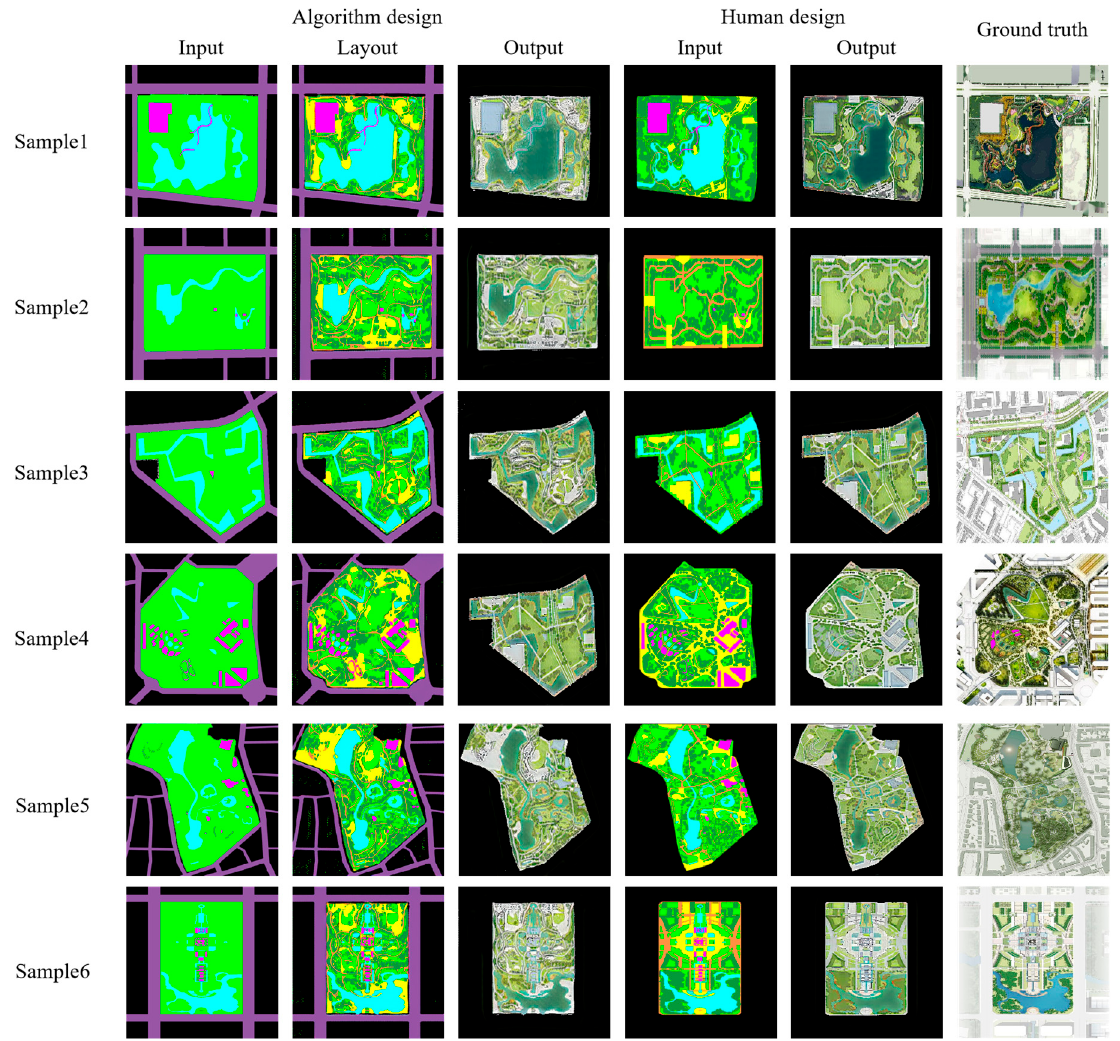
Figure 18. The comparation between AI-assisted design and AI full-flow automated design.